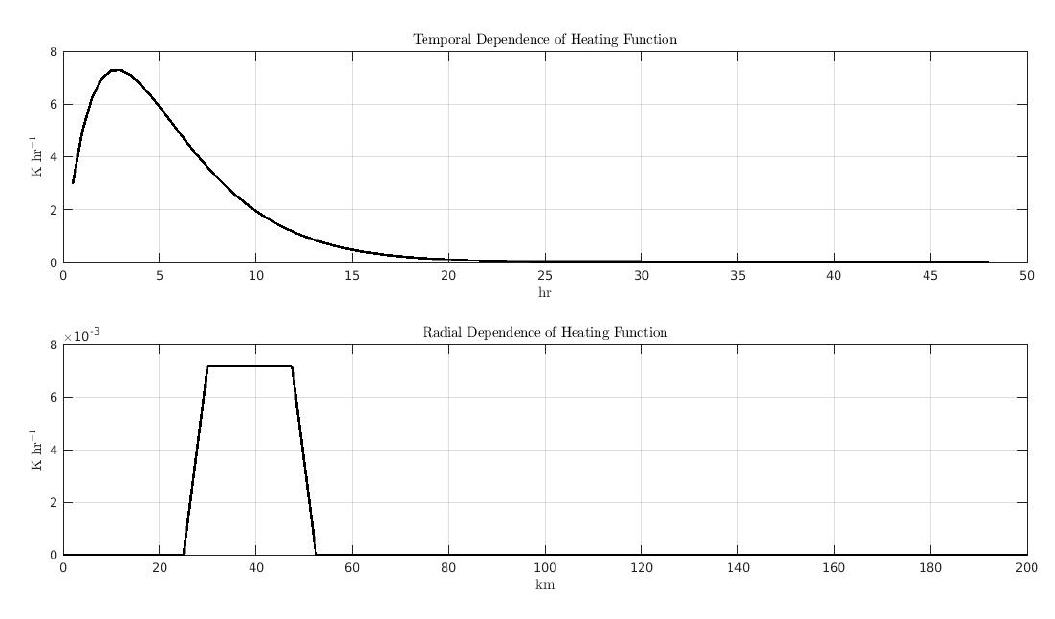
Figure 1. The heating function for the control experiment. (Top) The radial structure of the heating function profile (cid:1843)((cid:1870)) ; (Bottom) The temporal structure of the heating function (cid:1843) (cid:3032)(cid:3050) (cid:2009)(cid:1872) exp(−(cid:2009)(cid:1872))